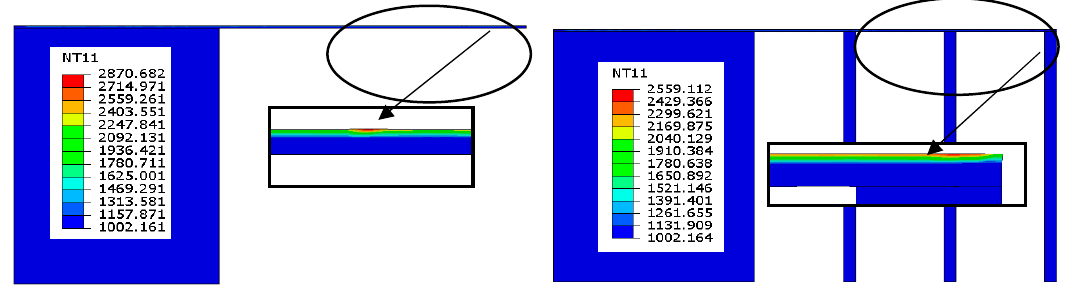
Figure 11. Temperature distributions (K) during 3rd layer build.